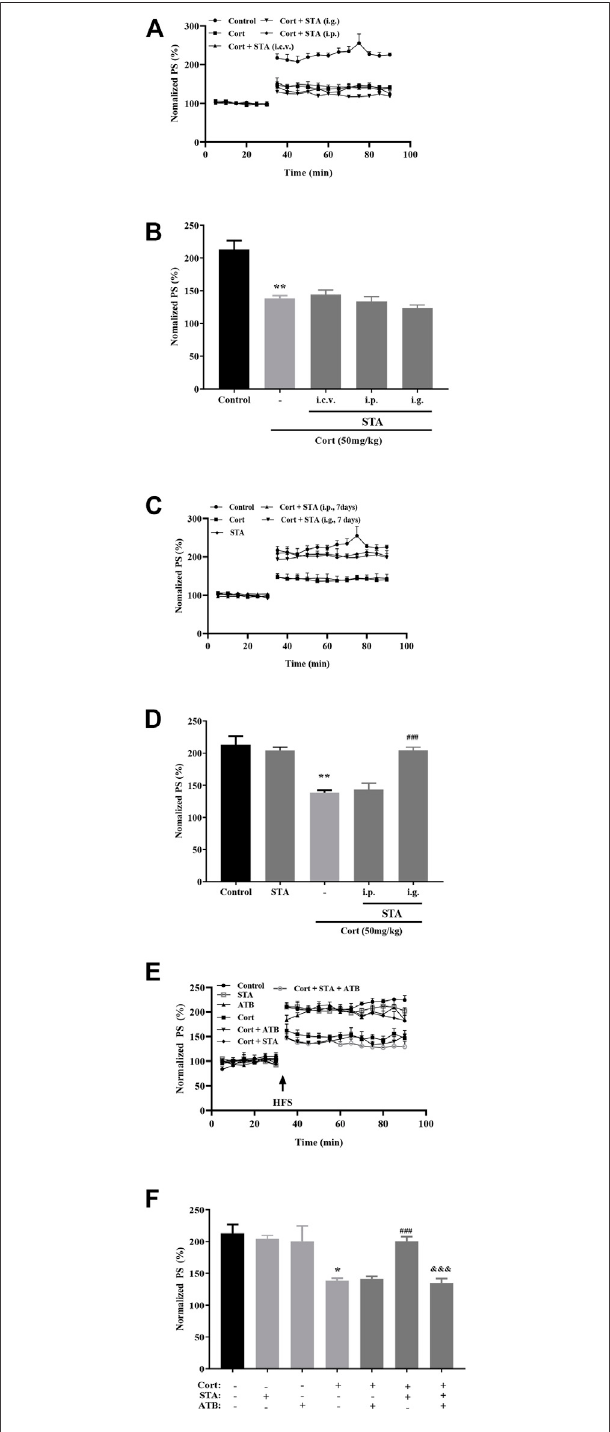
FIGURE1| PSamplitudes. (F) AveragerelativePSamplitudesafterHFS.ATB was administrated 30 min before STA (i.g.). Data are shown as the mean ± SEM, n = 4 − 6. * p < 0.05, ** p < 0.01 compared to the Control group; ### p < 0.001comparedtotheCortgroup; &&& p < 0.001compared totheSTA+Cort